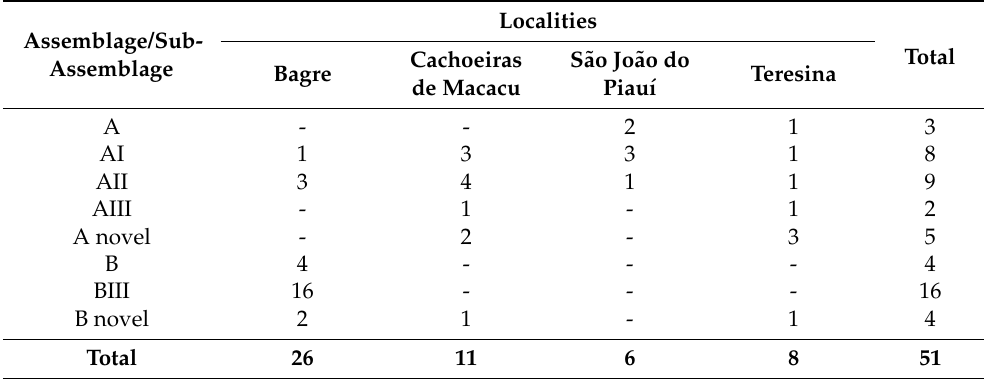
Table 2. Distribution of Giardia duodenalis assemblages and sub-assemblages obtained in this study based on β -giardin locus (592 bp, n = 51). Localities Assemblage/Sub- Total Cachoeiras S ã o Jo ã o do Assemblage Teresina Bagre de Macacu Piau í A - - 2 1 3 AI 1 3 3 8 AII 3 4 AIII - A novel - 2 - B 4 - - - 4 BIII 16